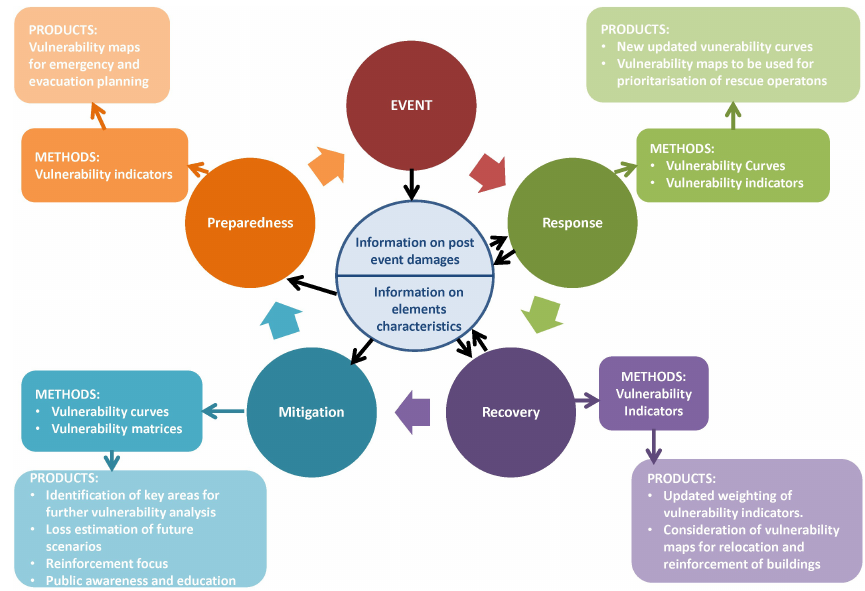
Figure 9. The role of vulnerability assessment and the corresponding methodological concepts in the phases of the disaster cycle (Papathoma- Köhle and Ciurean,